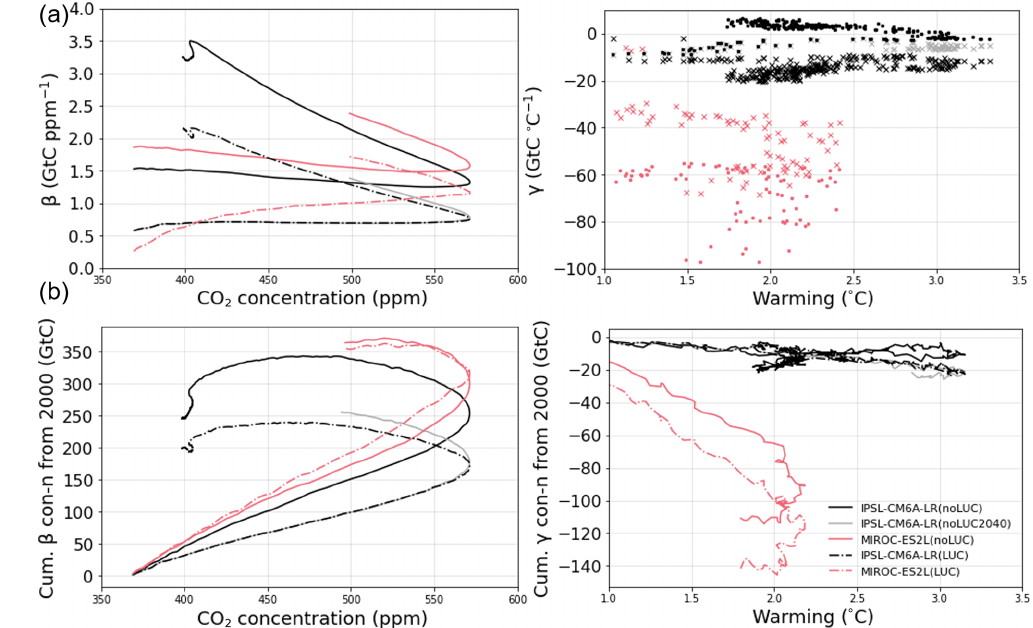
Figure 6. The variation of (a) global β land (GtCppm − 1 ) and γ land (GtC ◦ C − 1 ), and (b) cumulative over 2000–2300 (for IPSL-CM6A-LR) and over 2000–2100 (for MIROC-ES2L) β - and γ -driven land carbon uptakes with and without LUC. The changes in LUC are given as 9-year moving averages; negative value corresponds to a land